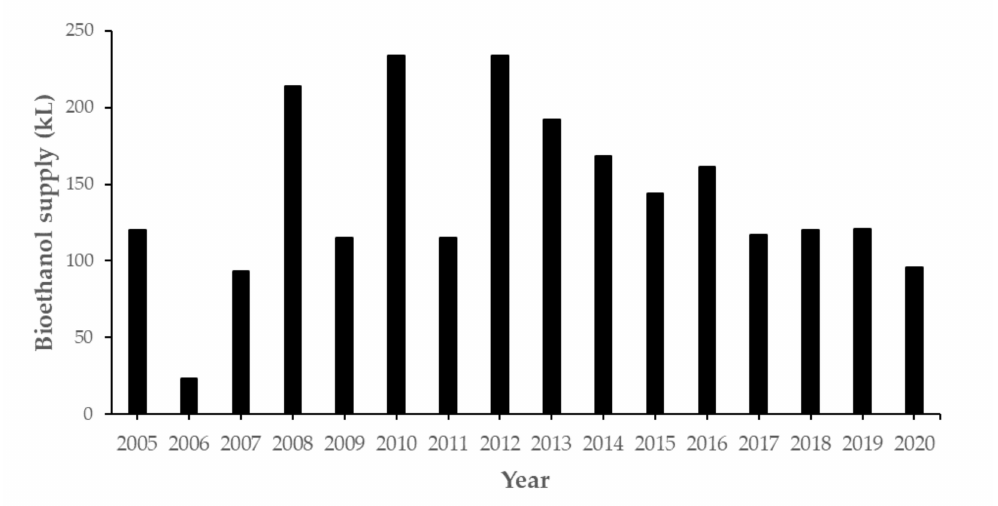
Figure 2. Variations of bioethanol supply during the period of 2007–2020 in